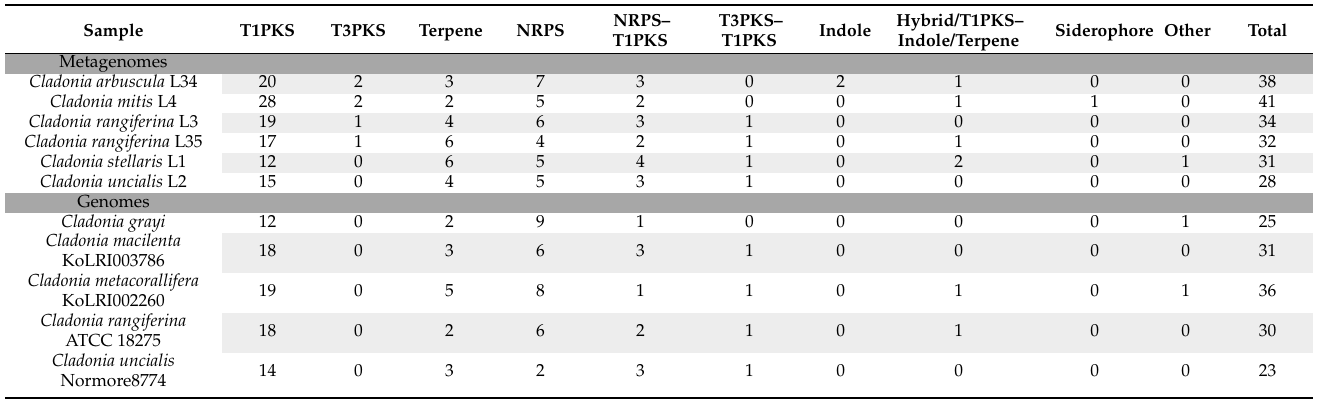
Table 1. Potential biosynthetic gene clusters detected by